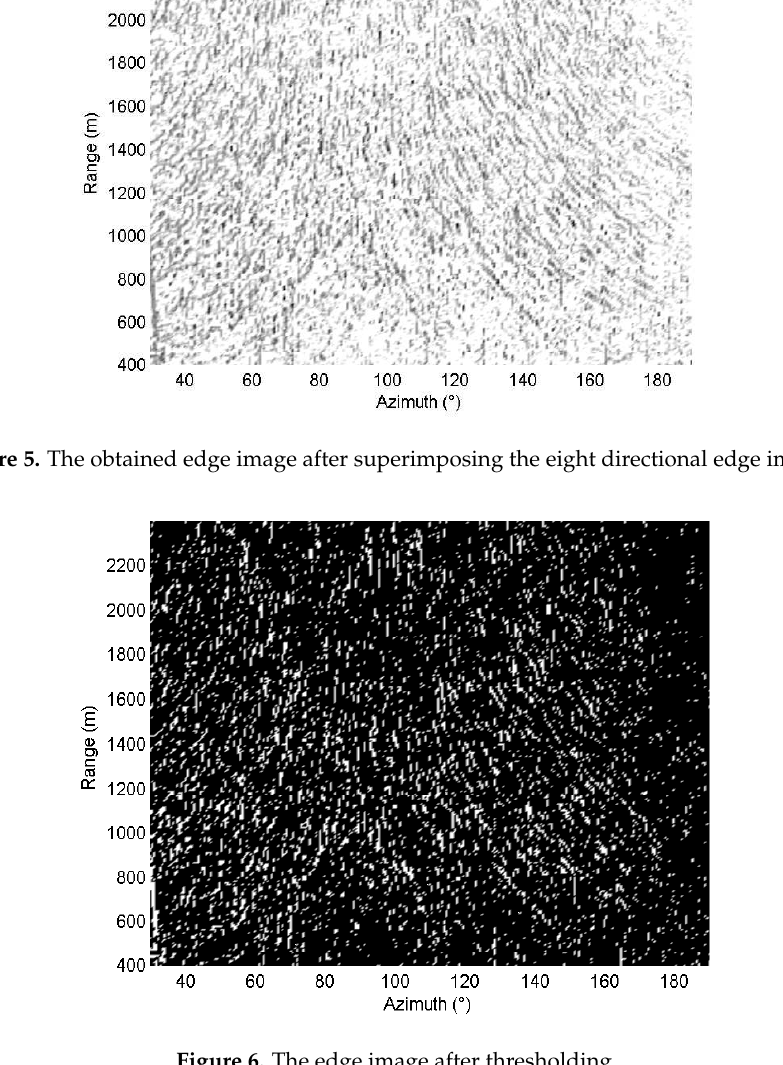
Figure 6. The edge image after